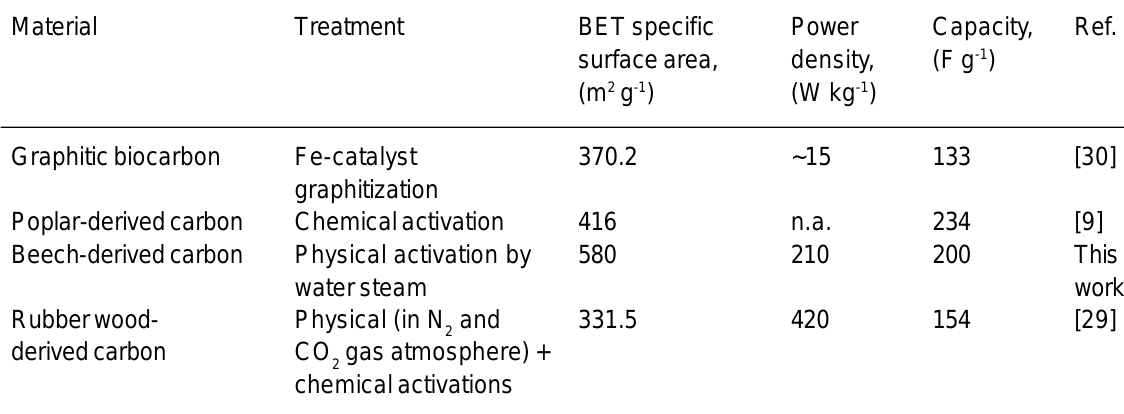
Table 4. Comparison of the preparation methods, specific surface area, capacitance and power density for different monolith wood-derived